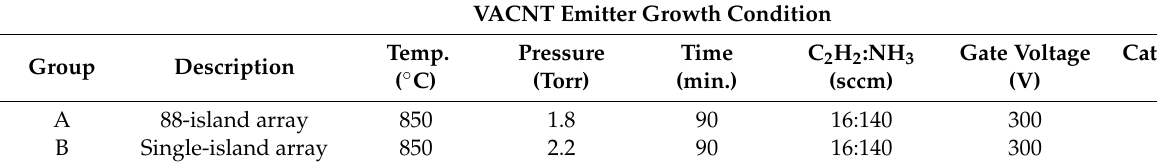
Table 1. Growth condition of VACNT emitters.